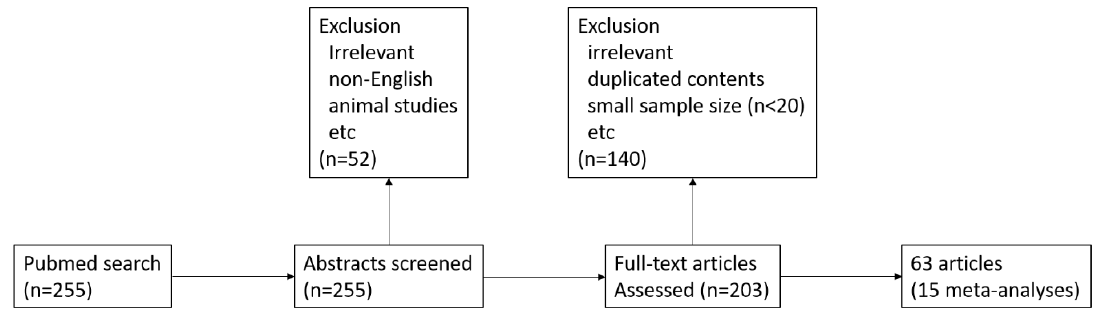
Figure 1. Flowchart of the article selection process.